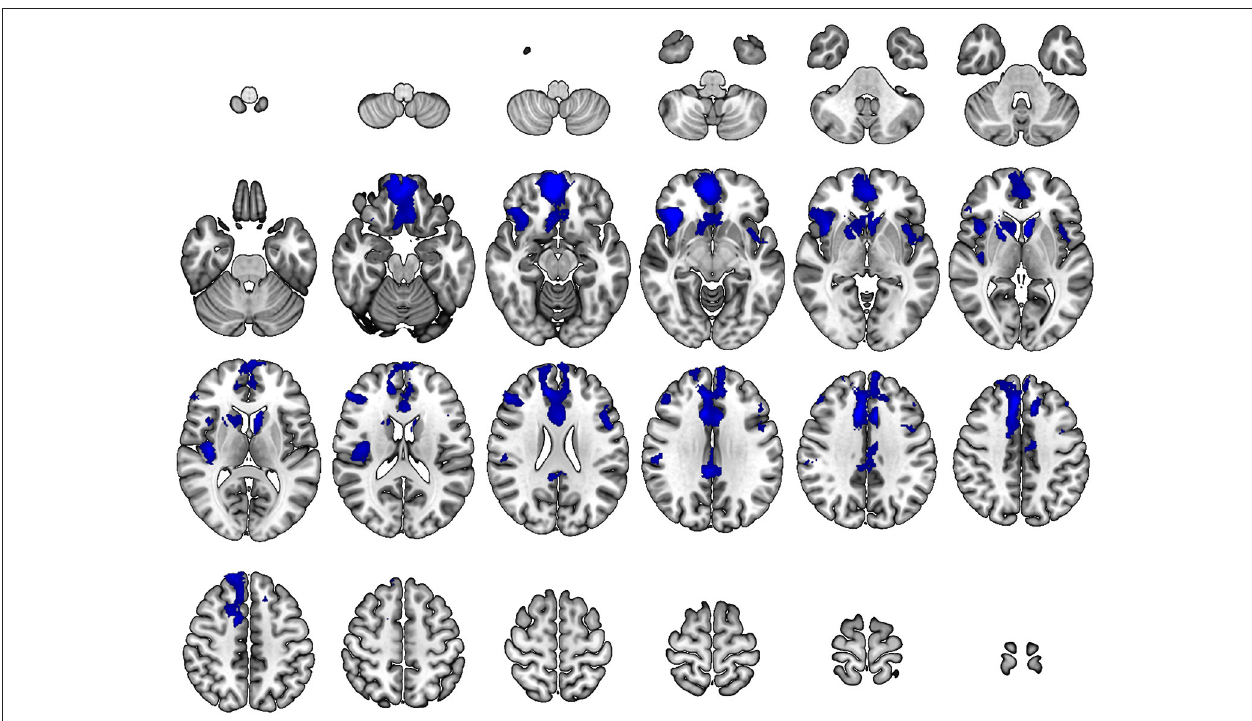
FIGURE 1 | Differences in regional cerebral blood flow between patients with neurosyphilis and healthy controls. At each voxel, decreases in brain perfusion in neurosyphilis patients compared with healthy controls appear in blue. The height threshold is p < 0.001 with a cluster-level family-wise error correction at p < 0.05. Images are shown in radiological